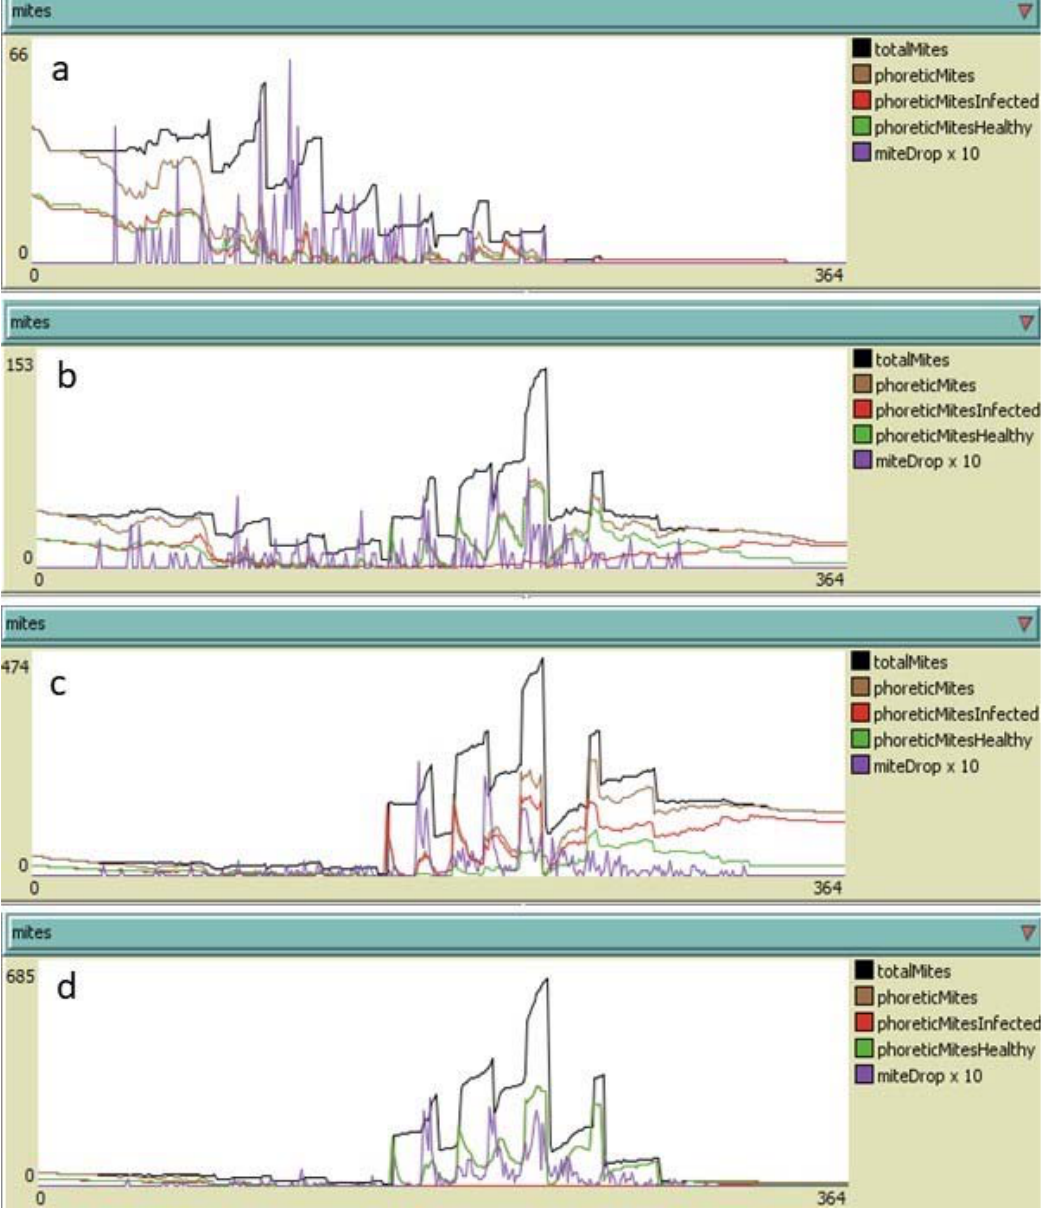
Figure 10. Yearly development of Varroa destructor infestation in colonies subjected to nine heat treatments under different hypotheses of re-infestation and dripped oxalic acid treatment: ( a ) no re-infestation and a single acid oxalic treatment at the end of July; ( b ) 30 mites per month from June to September (120 mites in total) and a single oxalic acid treatment at the end of July; ( c ) 150 mites per month from June to September (600 mites in total) and a single oxalic acid treatment at the end of July; ( d ) 150 mites per month from June to September (600 mites in total) and one oxalic acid treatment per month from the end of July to the end of October (4 treatments). Adult mites alive on 31 December: ( a ) 0; ( b ) 18; ( c ) 133; ( d ) 12.